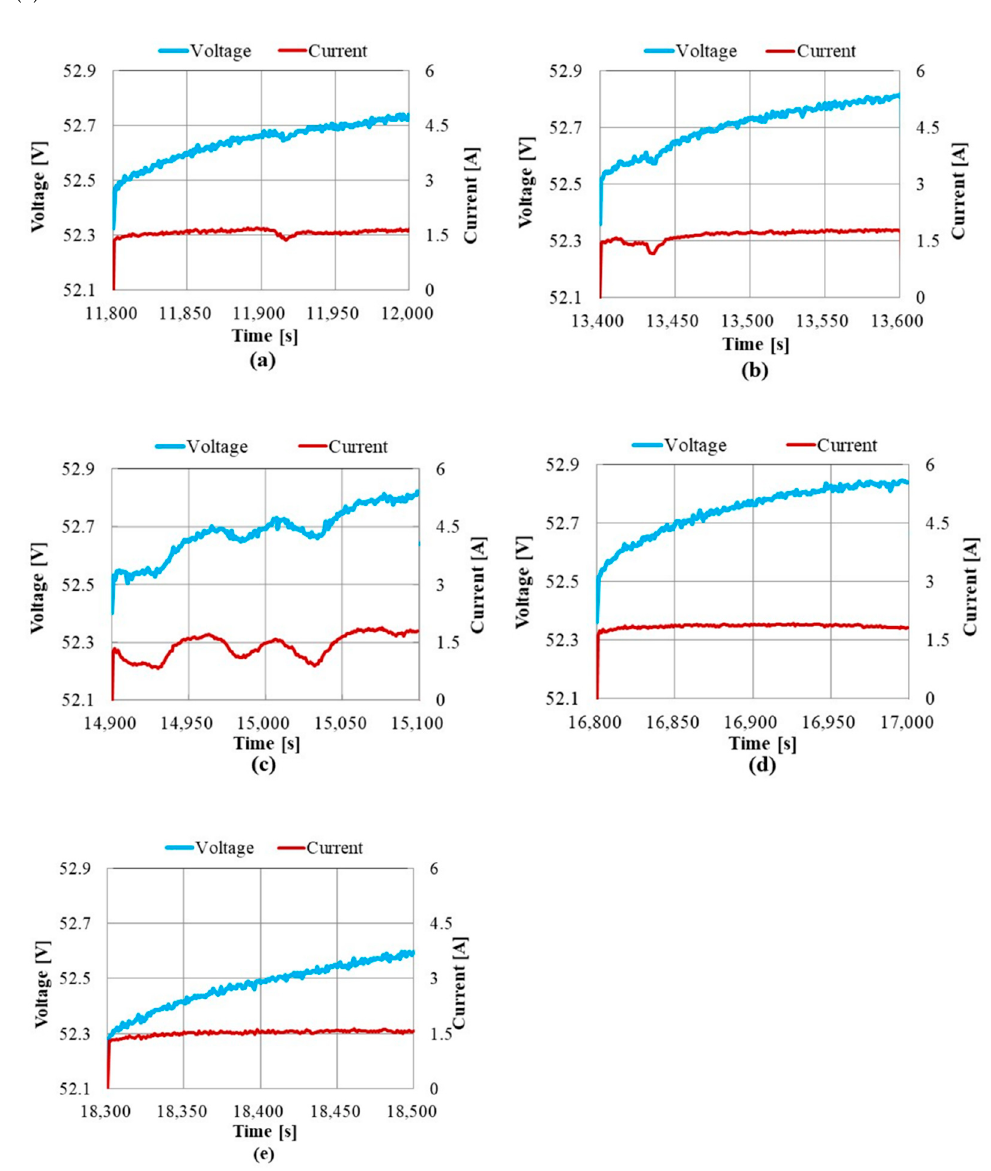
Figure 19. Battery voltage and current waveforms of the DC distribution system. ( a ) Case 1. ( b ) Case 2. ( c ) Case 3. ( d ) Case 4. ( e ) Case 5.